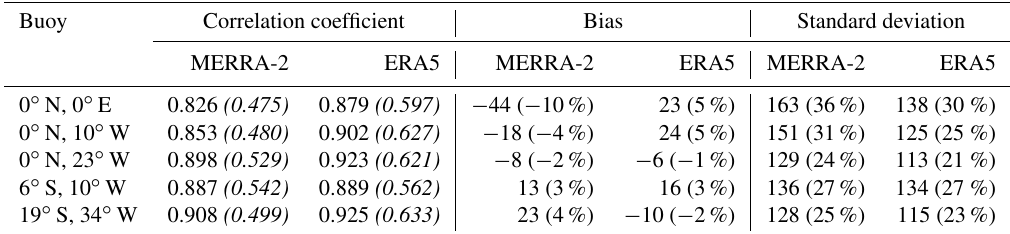
Table 5. Details for each PIRATA buoy and each re-analysis data set: correlation coefficient between measurements and estimates from re-analysis for irradiance and clearness index (in italics), bias and standard deviation (Wm − 2 ) between measurements and estimates for irradiance with relative values (in brackets) for hourly means in the period 2012–2013. Buoy Correlation coefficient Bias Standard deviation MERRA-2 ERA5 MERRA-2 ERA5 MERRA-2